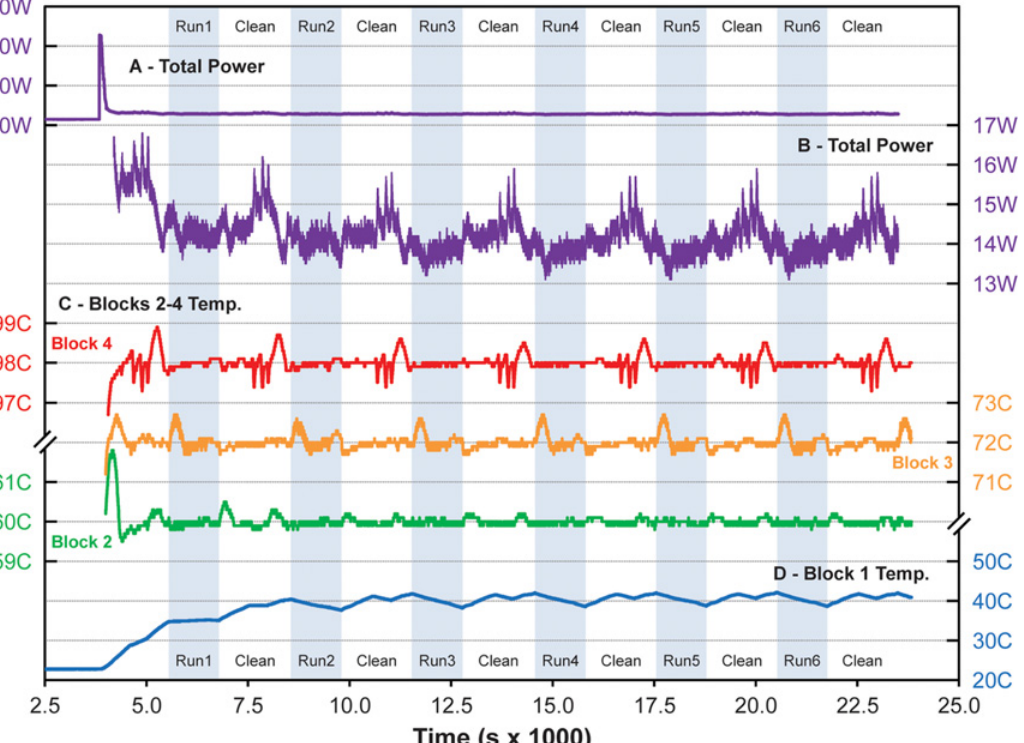
Fig 9. RZTC power and temperature history from startup for six Phusion rzPCR experiments with thermal cycling intervals indicated by the shaded bands. (A) Total (wall) power drawn by the heater control box during initial idle, warm-up, and cycling. (B) Detail of power fluctuations during cleaning, sample load, amplification, and sample unload. (C) Temperature fluctuations for heater blocks 2 – 4 about their set-points at 60°C, 72°C, and 98°C. (D) Temperature evolution of unheated block 1 over